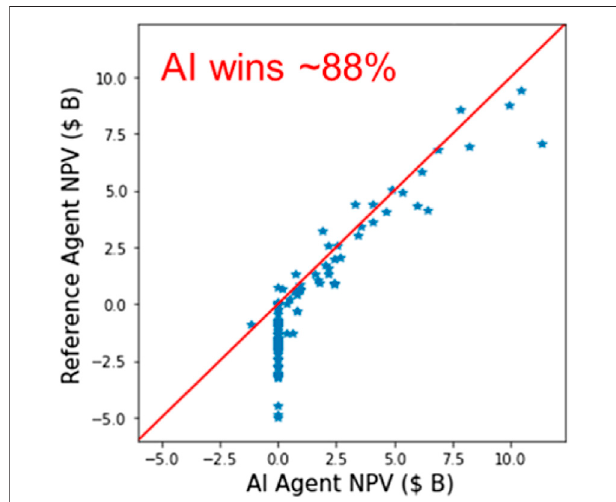
FIGURE 11 | Comparison of the best arti fi cial intelligence (AI) agent trained using the dual-action probability representation with the maximum NPV from the reference well-pattern agents for the 3D case.